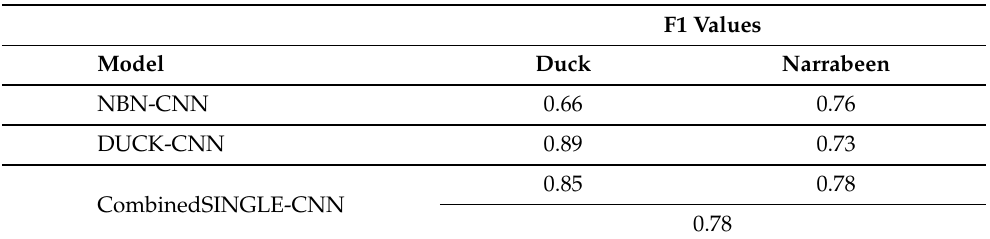
Table 7. F1-values for the single-barred beach models tested at Duck and